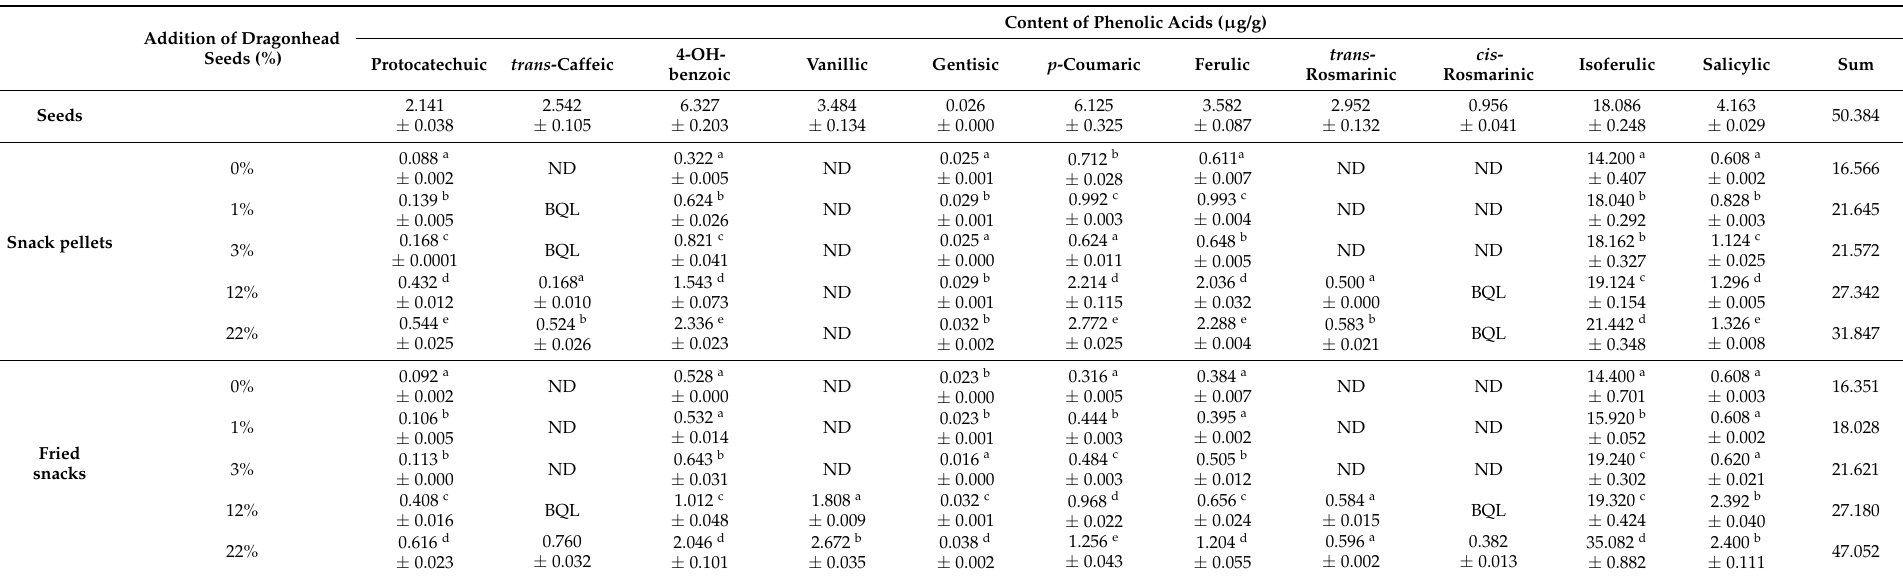
Table 2. Content of phenolic acids in snack samples enriched with dragonhead seeds and in dragonhead seeds ( n = 3; mean ± SD).